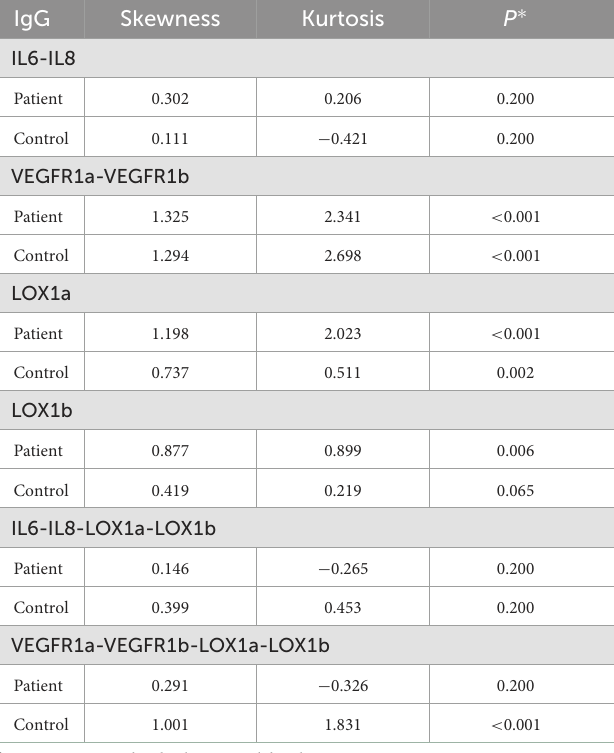
TABLE 3 Inter-assay deviation between plates tested.